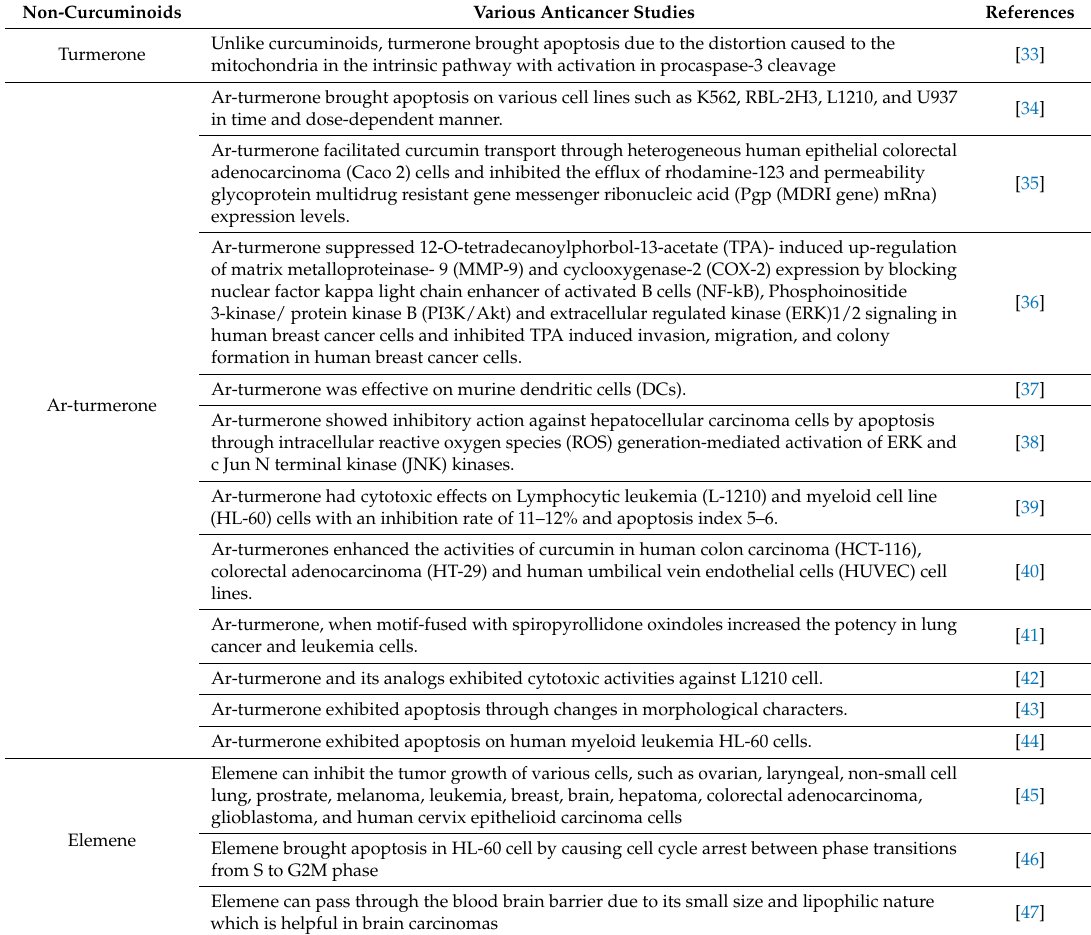
Table 2. Various anticancer activities of